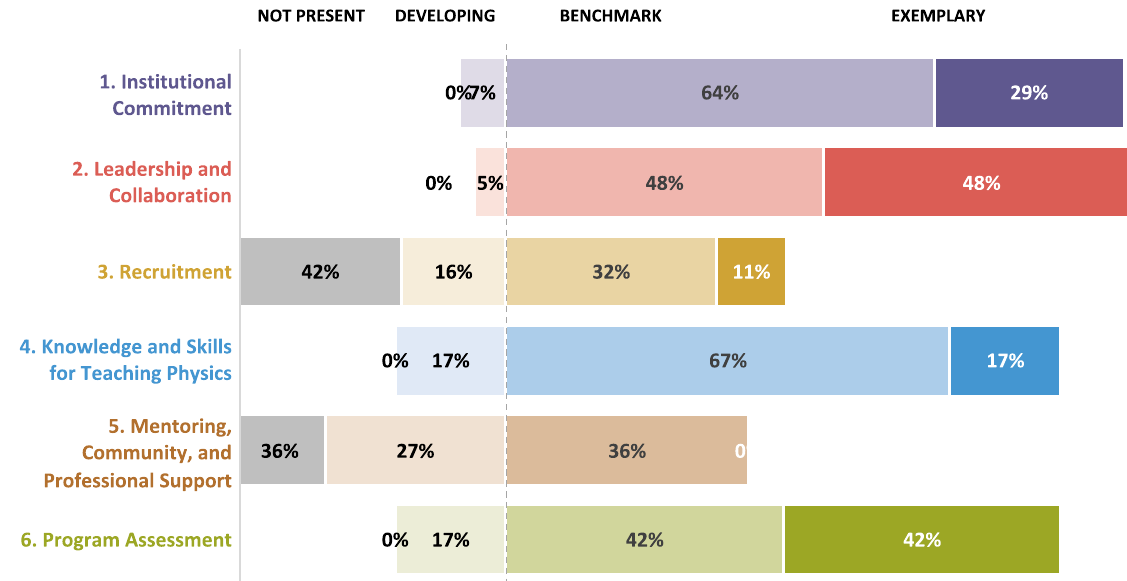
FIG. 1. Sample program data for the PTEPA rubric across the 6 standards, showing the percent of items rated not present (gray), developing (light shade), benchmark (medium shade), or exemplary (dark shade). Note that different standards have different numbers of items. Percents may not add to exactly 100% due to rounding.